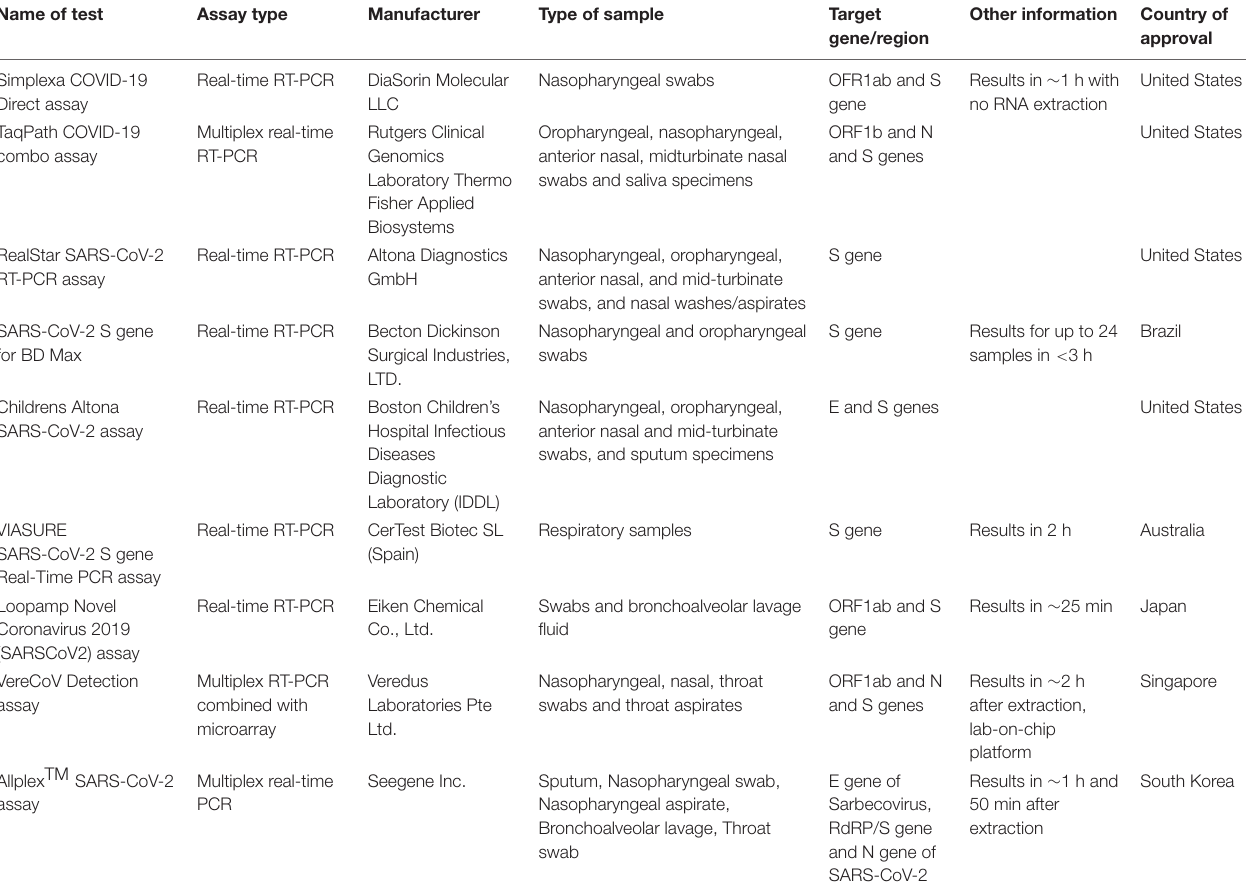
TABLE 1 | Molecular diagnostic assays used for the diagnosis of